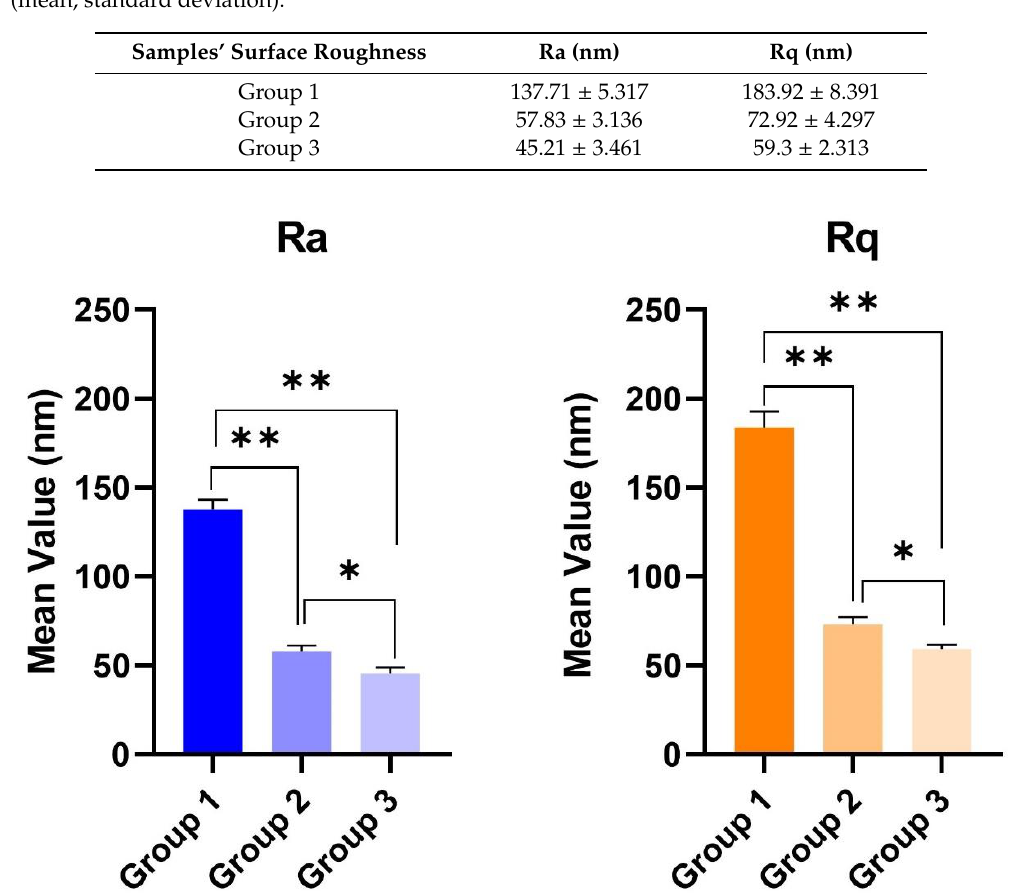
Table 1. Atomic Force Microscope (AFM) evaluation of the grade 4 titanium disks’ surface (n = 10 samples per group). Ra: Arithmetical mean deviation; Rq: Root mean square deviation (mean, standard deviation).